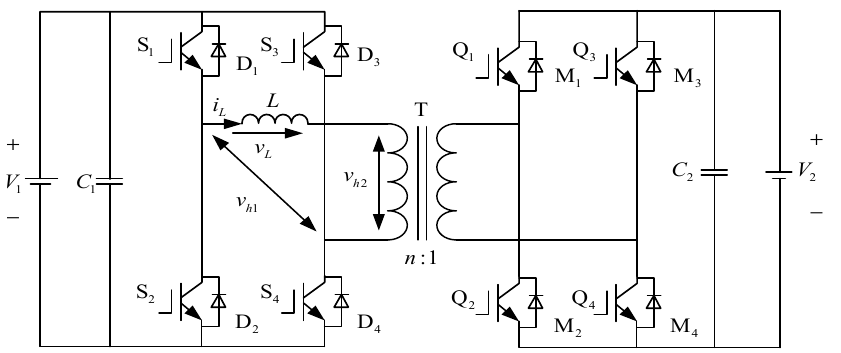
Figure 5. IBDC converter topology.